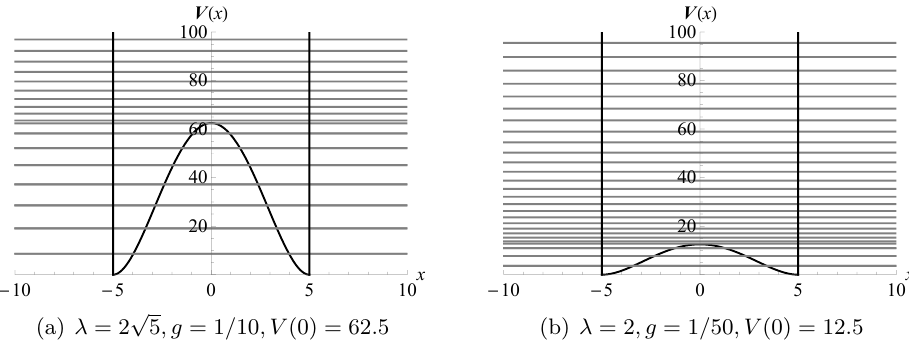
Figure 6 . Potential energy with hard walls and energy levels. The levels below the top of the hill are double